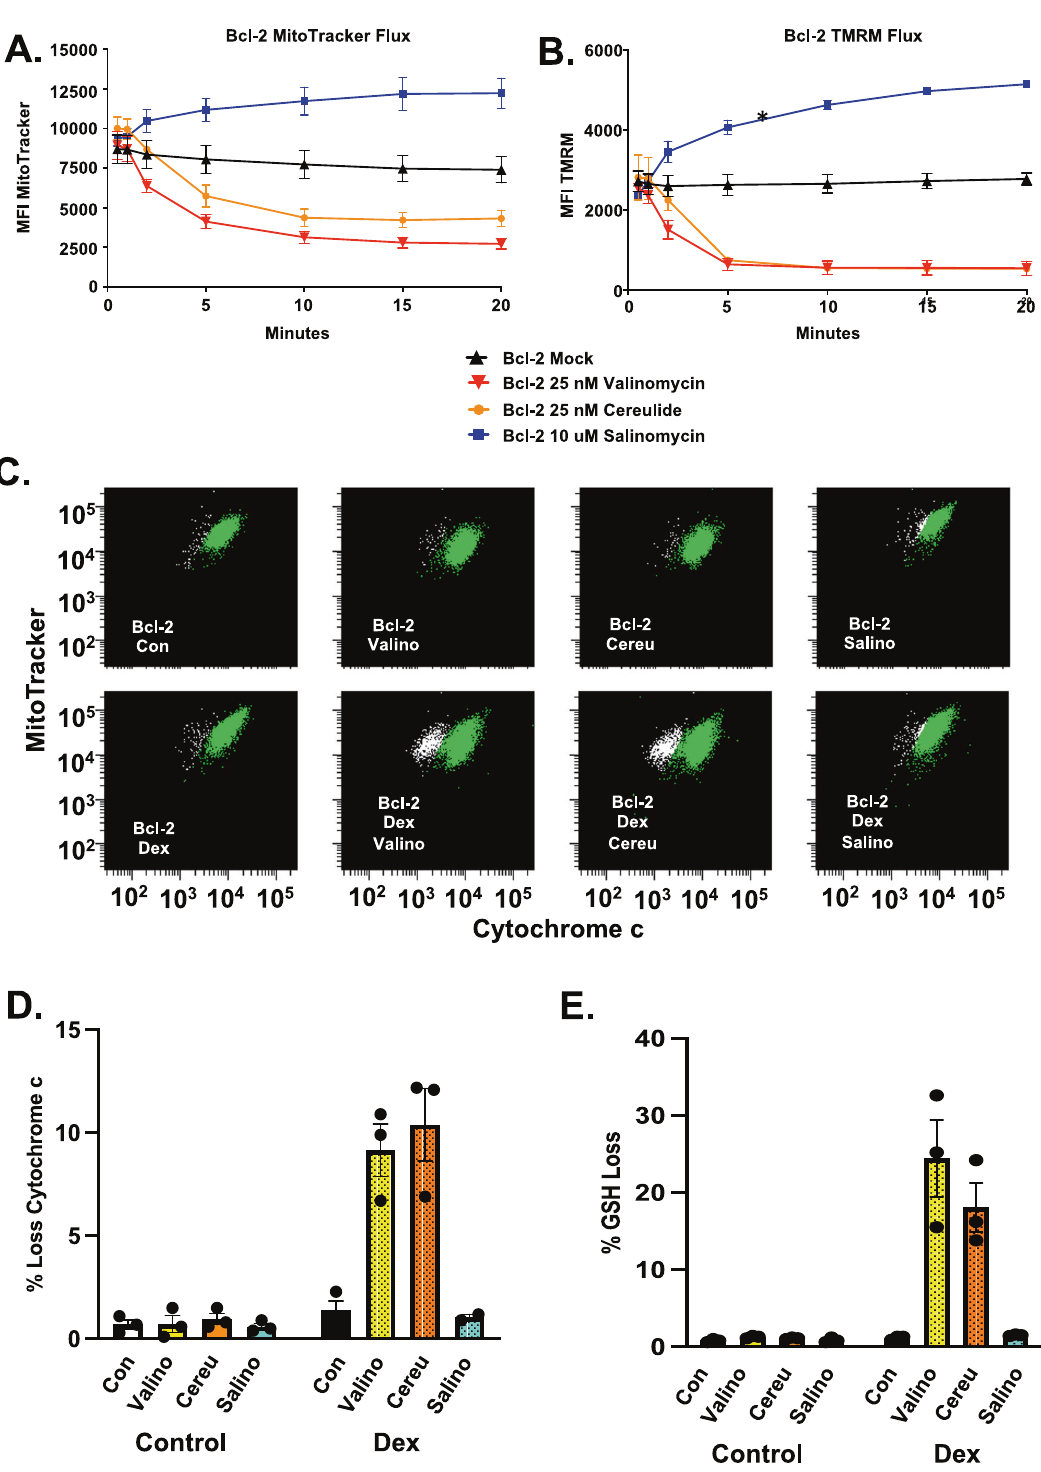
Fig. 6 Microbial toxins that override apoptotic resistance in Bcl-2 expressing cells depolarize the mitochondrial membrane potential. S49 (Bcl-2) cells loaded with either 25 nM MitoTracker Deep Red ( A ) or 50 nM tetramethylrhodamine methyl ester perchlorate (TMRM; B ) then treated with 25 nM valinomycin, 25 nM cereulide, or 10 uM salinomycin were examined for changes in their mitochondrial membrane potential (MMP) by fl ow cytometry. Data represent the mean ( + / − SEM) of 3 independent experiments. S49 (Bcl-2) cells were treated with 2.5 × 10 − 7 M dex for 48 h in the presence or absence of 25 nM valinomycin, 25 nM cereulide, or 10 uM salinomycin during the fi nal 6 h and examined for the loss of cytochrome c ( C , D ) and lose of glutathione ( E ). Data represent the mean ( + / − SEM) of 3 independent experiments. lymphoid cells expressing Bcl-2 develop several pro- and anti- DISCUSSION apoptotic features in the absence of cell death. Dex-treated S49 The expression of Bcl-2 protects lymphoid cells from cell death (Bcl-2) cells results in hyperpolarization of both the mitochondrial induced by glucocorticoids. However glucocorticoid treatment in Cell Death Discovery (2022)